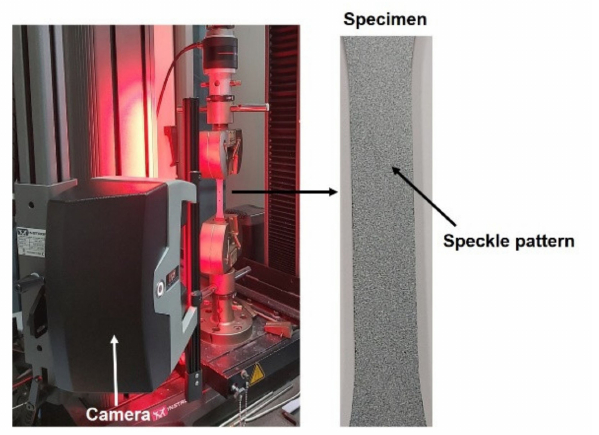
Figure 2. Instron UTM equipped with tensile fixture and non-contact strain measurement